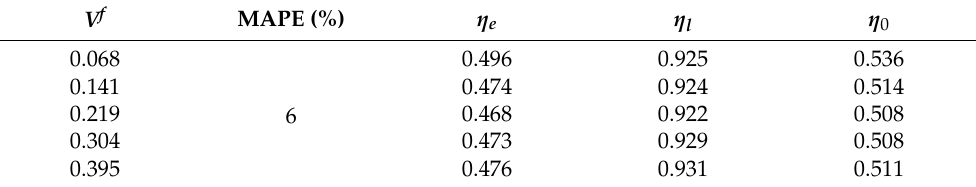
Table 3. Micromechanics factors for the Young’s modulus of biobased composites. V f MAPE